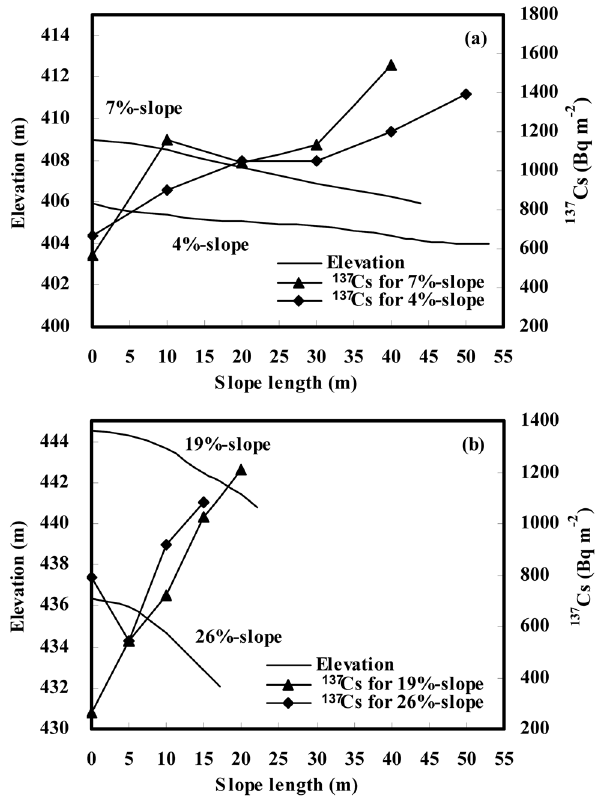
Figure 2. Distribution of 137 Cs inventories over eroded slopes. (a) gentle slope landscape; (b) steep slope landscape.